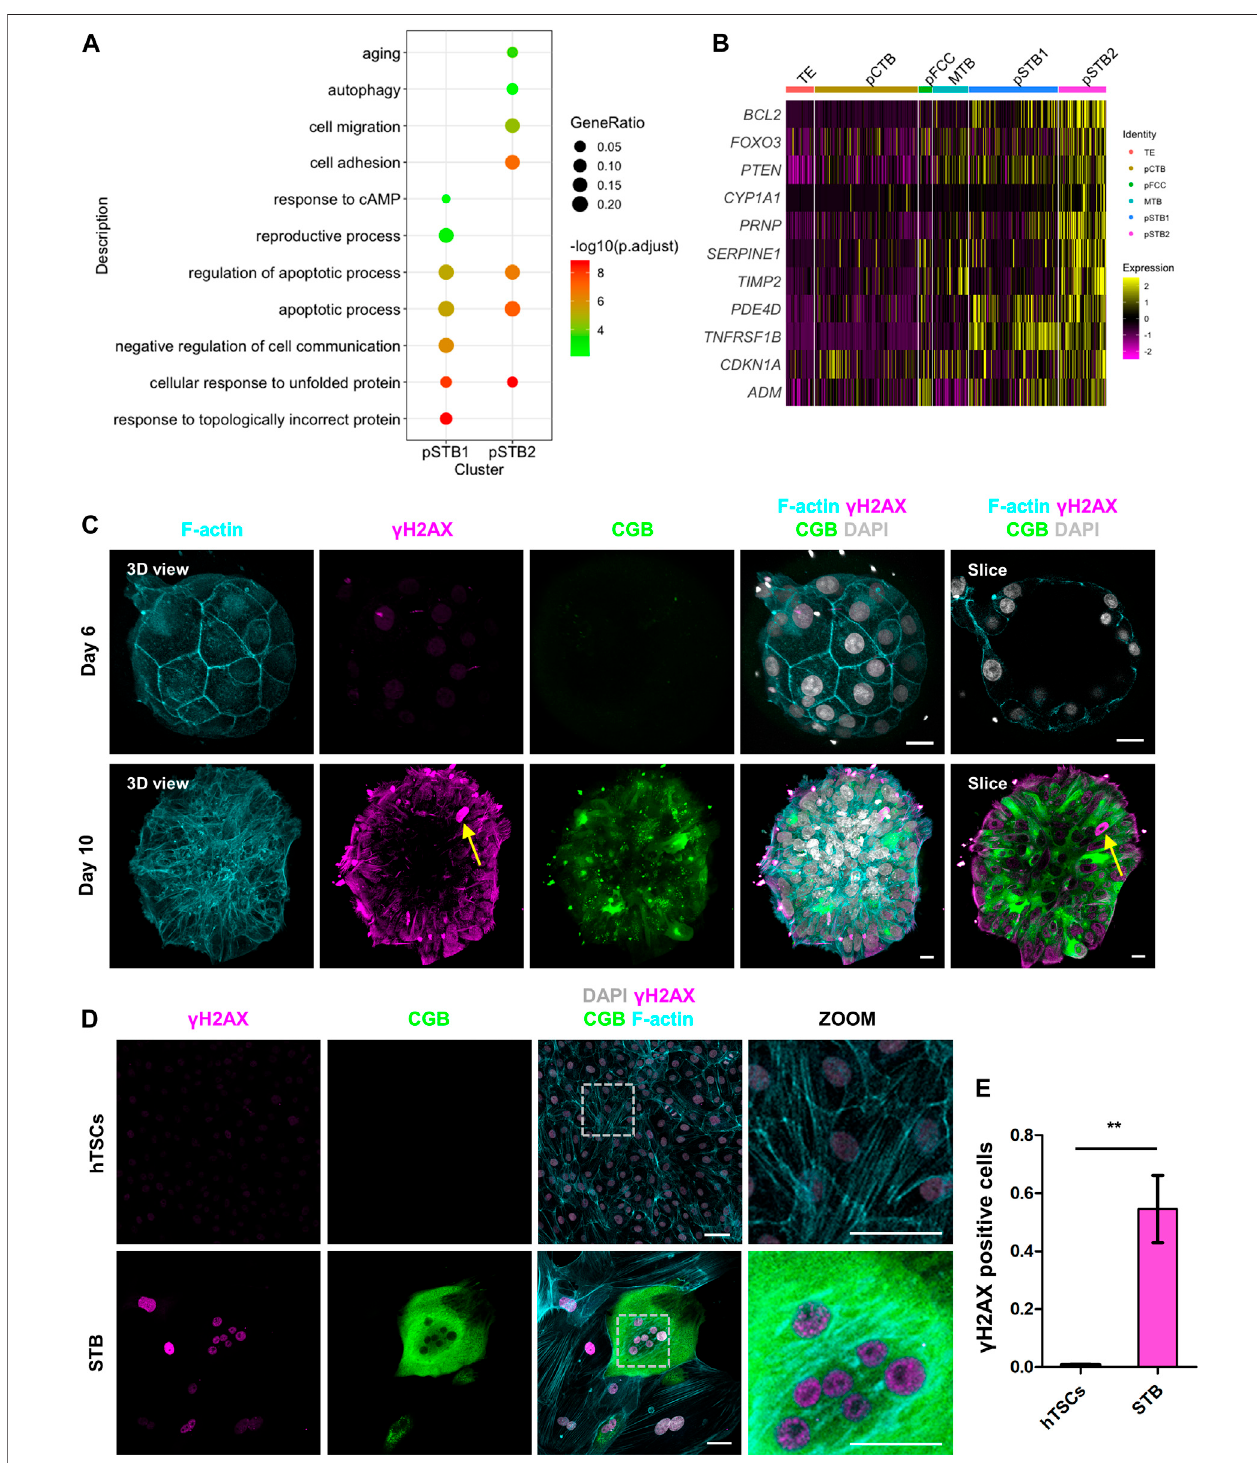
FIGURE 6 | Primitive syncytiotrophoblast is related to cellular aging. (A) Dot plots showing enriched GO terms and p -value of distinct clusters of trophoblast cells. (B) Heatmapofindicatedgenesindistinctclustersoftrophoblastcells.Thecolorkeyfrompurpletoyellowindicateslowtohighgeneexpressionlevels,respectively. (C) Immunostaining of day 6 and day 8 human embryos ( n = 3 and n = 3) cultured in vitro for F-actin, γ H2AX, and CGB. DAPI, grey, DNA. Scale bars, 20 μ m. (D) ImmunostainingofhTSCsandSTBfor γ H2AX,CGB,andF-actin.Dottedrectanglerepresentedregionsthatareshownwithhighermagni fi cation.DAPI,grey,DNA. Scale bars, 50 μ m. (E) Quanti fi cation of the numbers of γ H2AX positive nuclei in hTSCs and STB. Data are shown as mean ± SEM. n = 10 fi elds of view per group. Unpaired two-tailed Student ’ s t -test, ** p < 0.01.